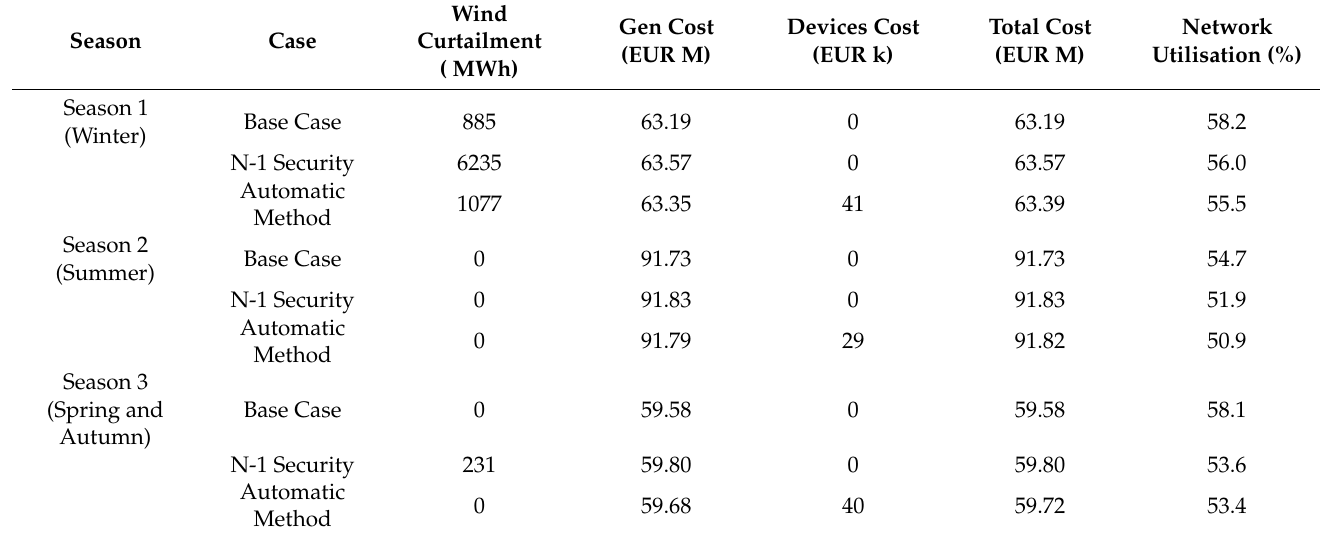
Table 4. Mobile MSSSC allocation simulation results with 2 × 75 MW